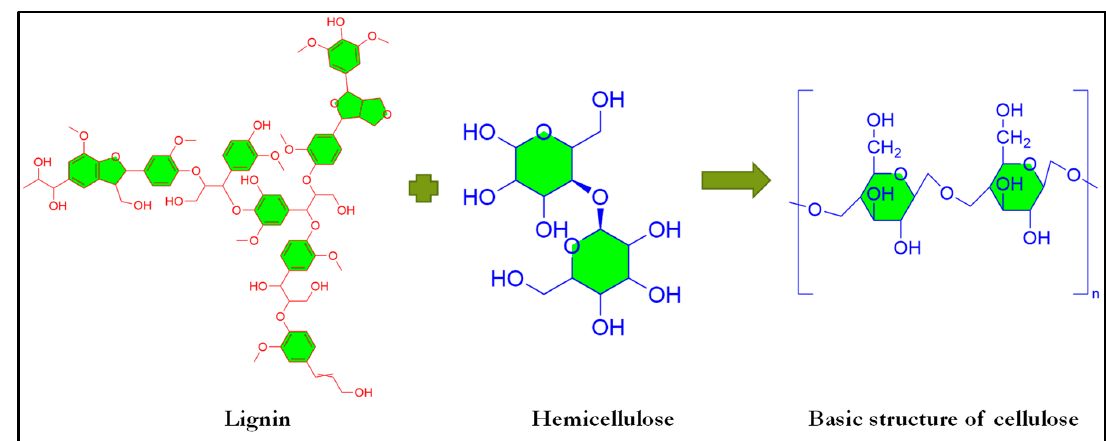
Figure 1. Schematic of the basic structural composition of cellulose.